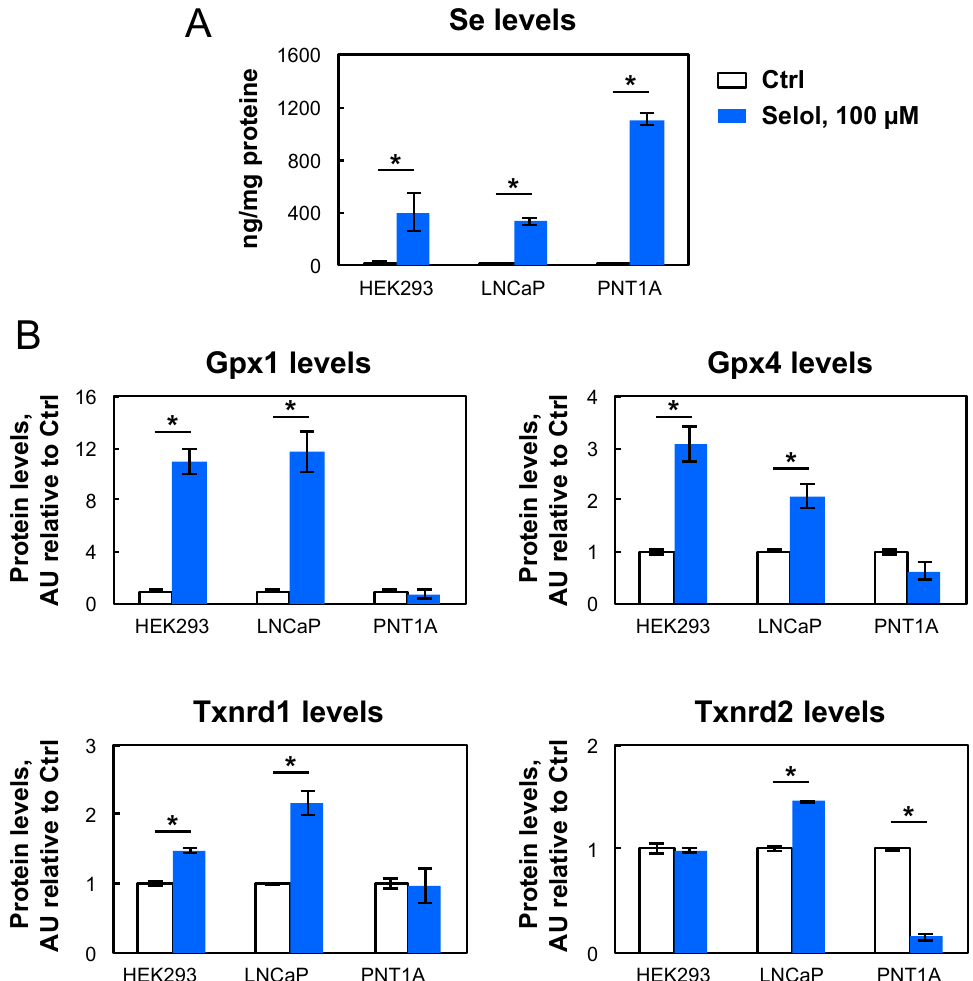
Figure 7. Comparison of Selol activities in three different human cell lines. ( A ) Selenium content in HEK293, LNCaP, PNT1A treated or not with 100 µM Selol. ( B ) Quantification of selenoprotein expression levels detected in Figure 6, normalized over the actin signal, in response to Selol supplementation. The significantly different (student test, p < 0.01) variations are indicated with an asterisk above the respective bars.